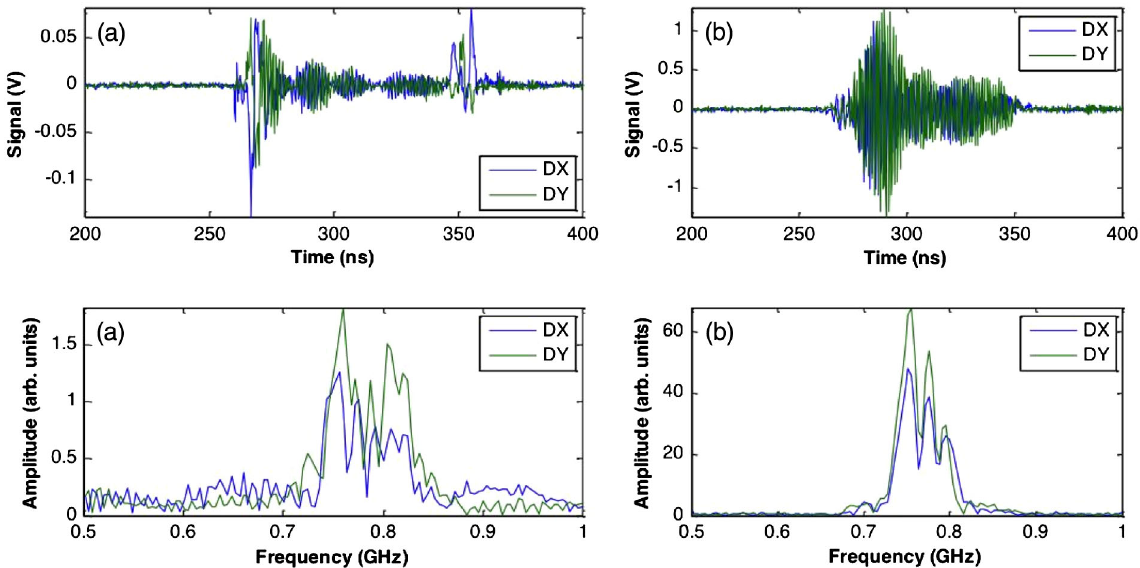
FIG. 5. Top row: Unintegrated Δ x and Δ y signals measured at BPM 20 ( z ¼ 36 . 1 m). Bottom row: Fast Fourier transform of the signal above to indicate the amplitude and frequency of the BBU on the beam for (a) the 1.7 kA beam and (b) Tune 4 for the 2.9 kA beam (note scale